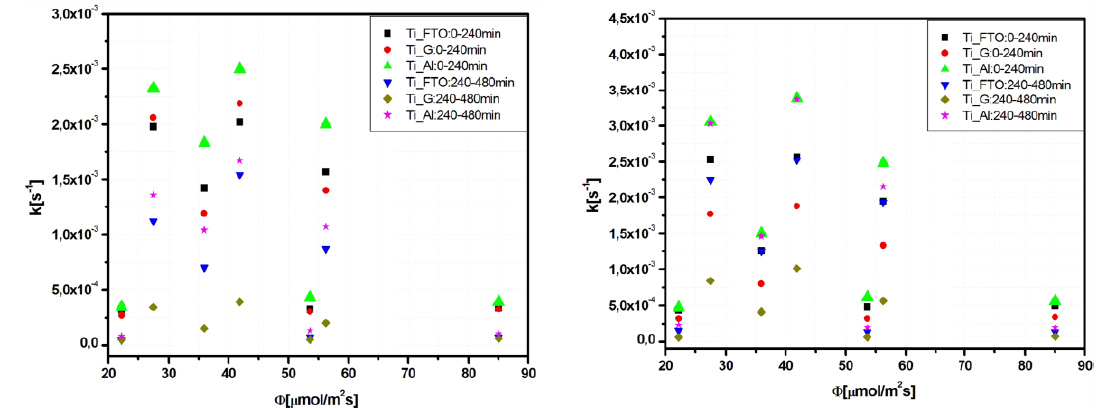
Figure 9. Variation of the rate constants with photon flux for ( a ) Tr and ( b ) Apd photodegradation.